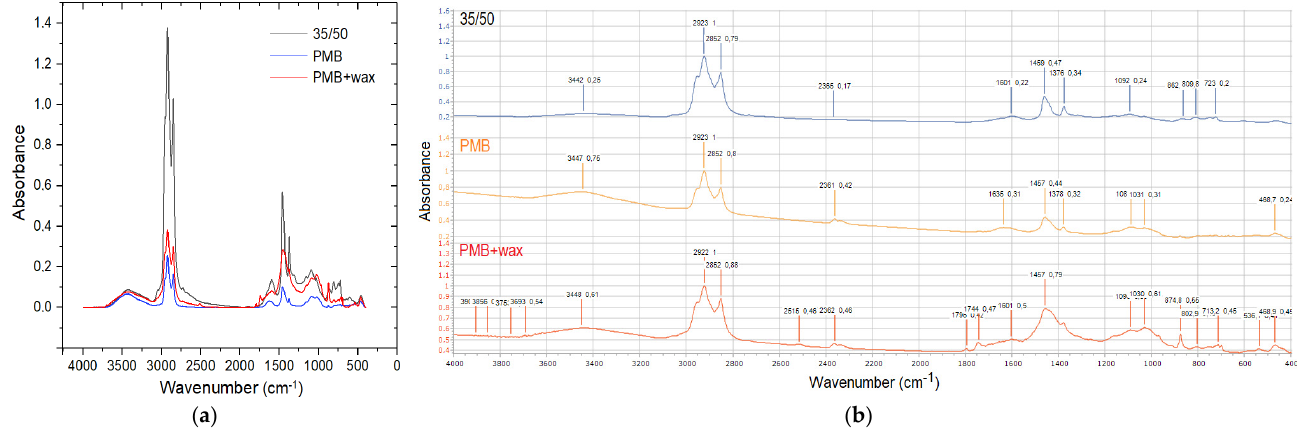
Figure 7. Binders—FTIR spectra (35/50, PMB, PMB+wax): ( a ) overlaid on the graph; ( b ) stack spectra (normalized).